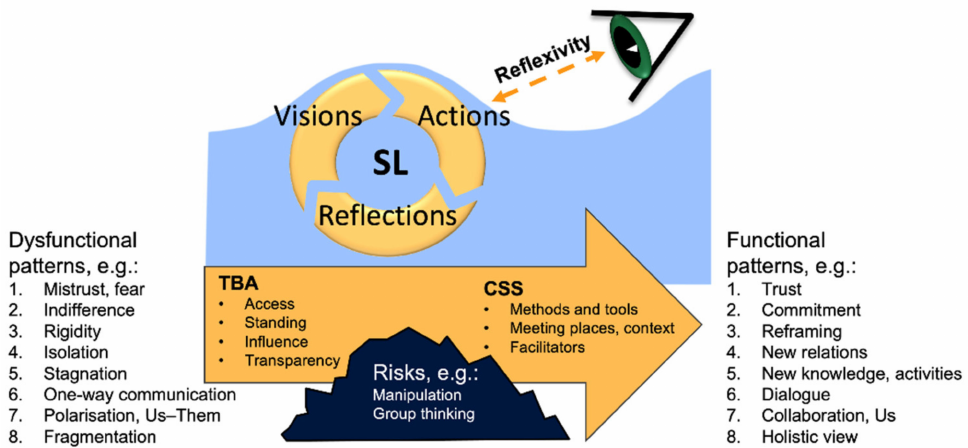
Figure 9. Managing dysfunctional patterns in SL processes—important linkages. Source: authors, based on Nolbrant [49] and inspired by Sannum and Nolbrant [66]. Published with permission by